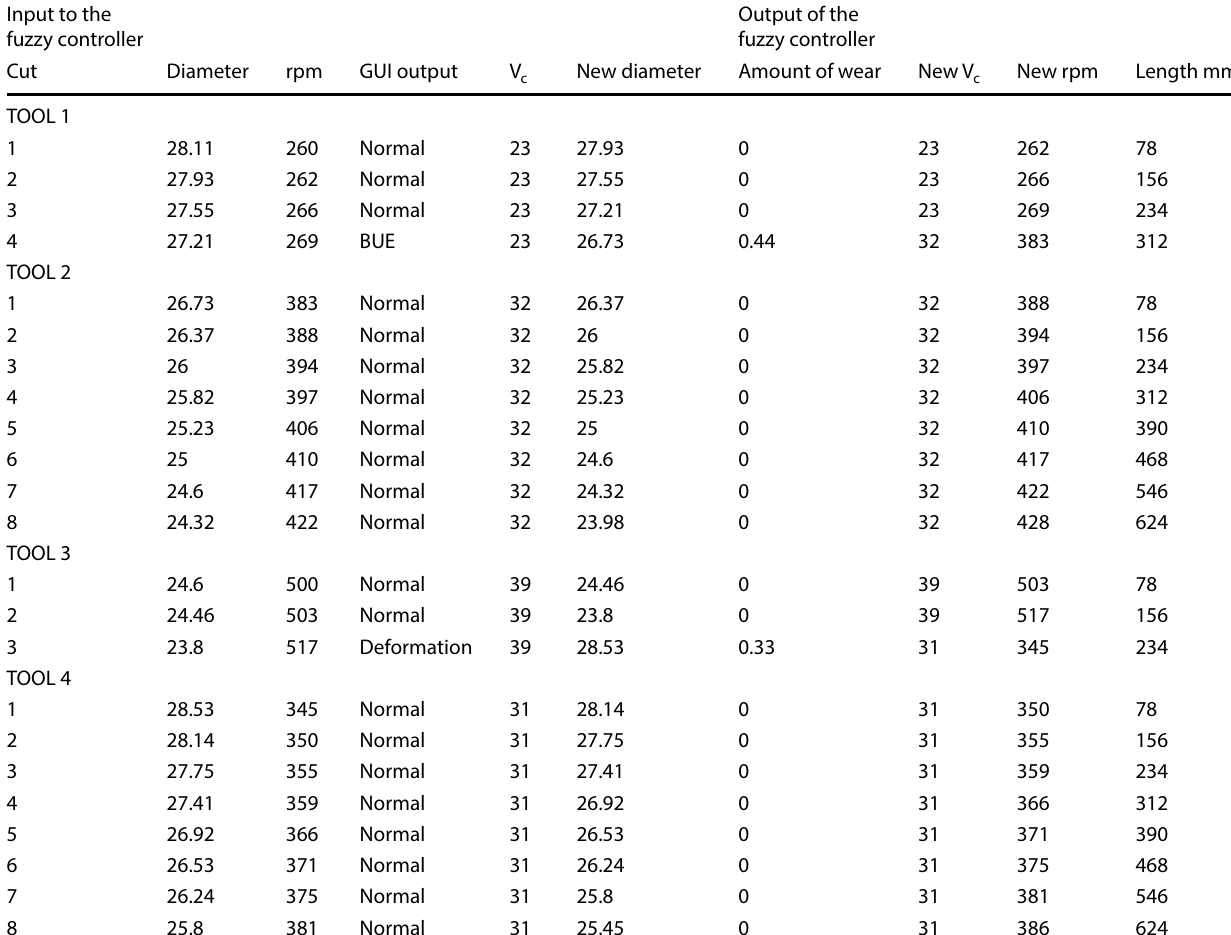
Table 8 Hybrid fuzzy controlling experimental data Input to the fuzzy